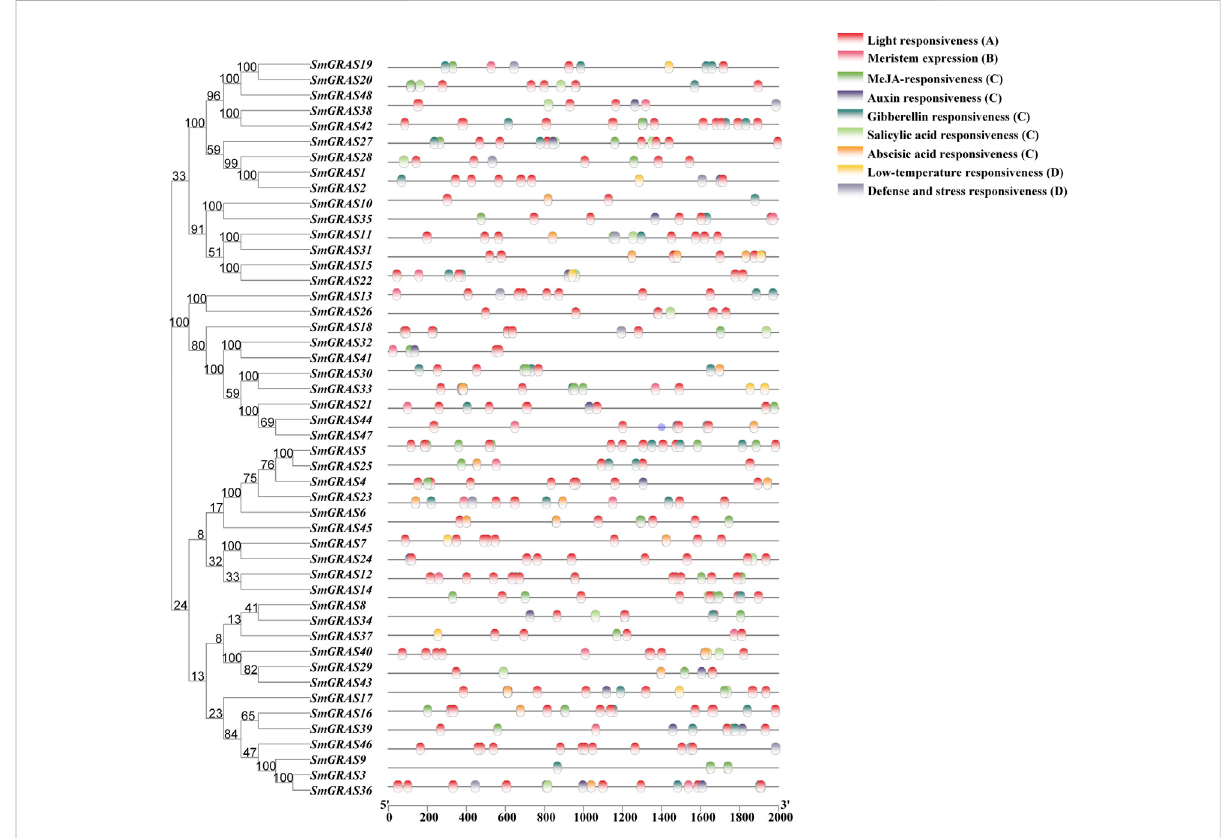
FIGURE 5 Cis -acting element analysis of SmGRAS s. Note: (A) Photoresponsive cis-acting element; (B) growth- and development-related cis-acting element; (C) hormone response-related cis-acting elements; (D) cis-acting elements associated with